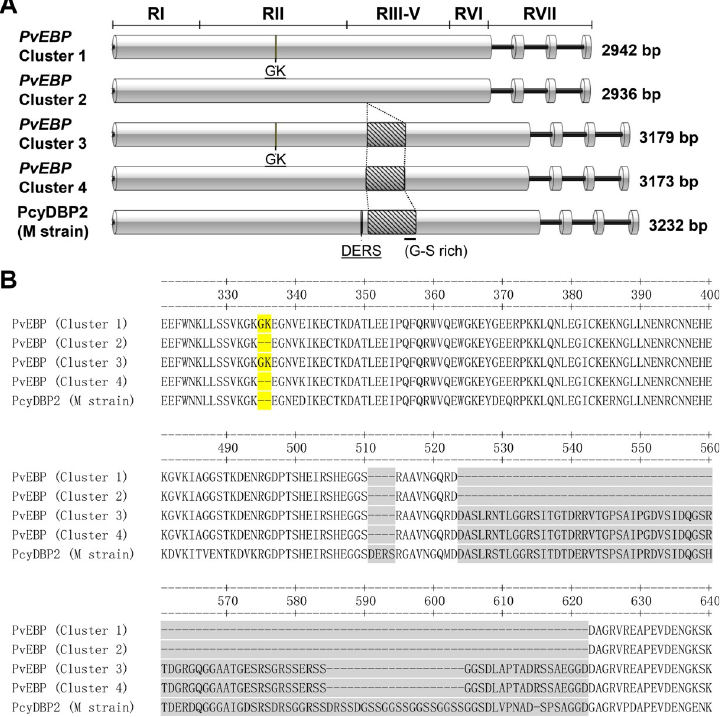
Fig 1. Pvebp primary structure and phenotypic clustering. (A) Disc shape shows pvebp exon and solid line represents intron part. Region separation was followed by PvDBP region divided strategy on cluster 1. The line in the box represents indels variation sites (GK or DERS). Cluster 3, 4, and PcyDBP2 (M strain) sequences have large insertions (oblique line box) in RIII-V domain. (B) Amino acid sequence alignment with PvEBP cluster shows in yellow background for Gly-Lys (GK), and gray background shows large indels variation.